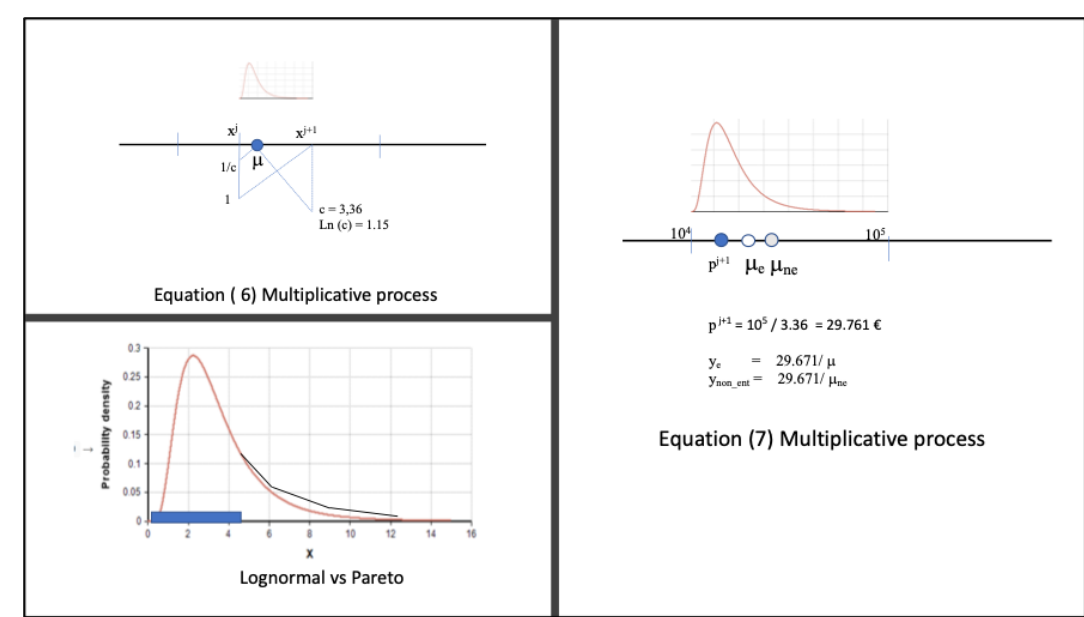
Figure 12. Interpretation of Equation (6)–(8).